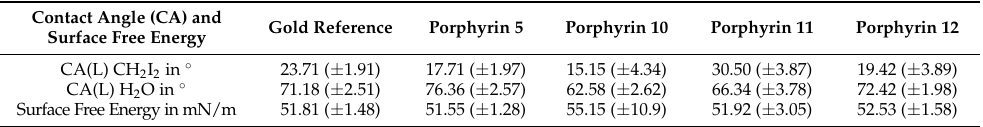
Table 2. Contact angles of gold reference, porphyrin 5 on gold and porphyrins 10 – 12 on gold. For the sessile drop method deionized water und diiodomethane were chosen as solvent. Surface free energy was calculated with the Owens, Wendt, Rabel and Kaelble (OWRK) model [34]. Contact Angle (CA) and